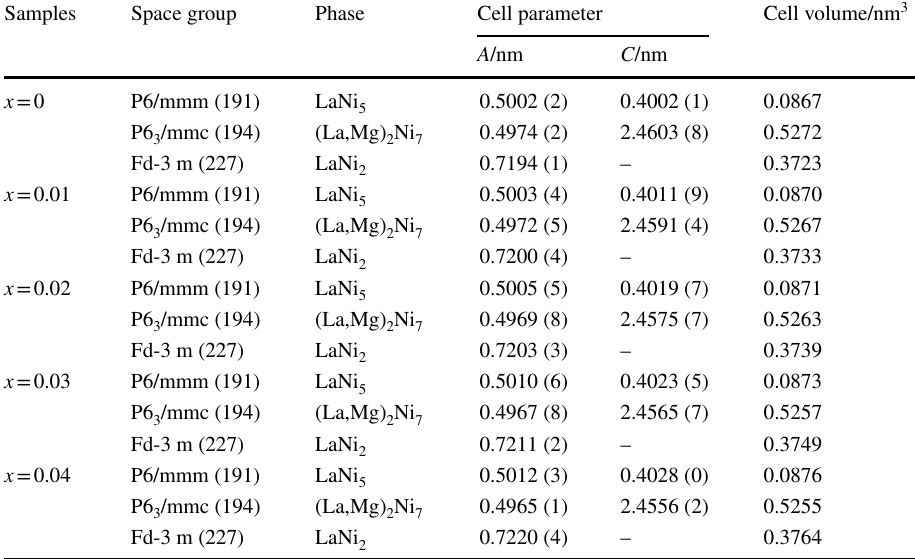
parameter of Re 2 Mg(Ni 0.7 − x Co